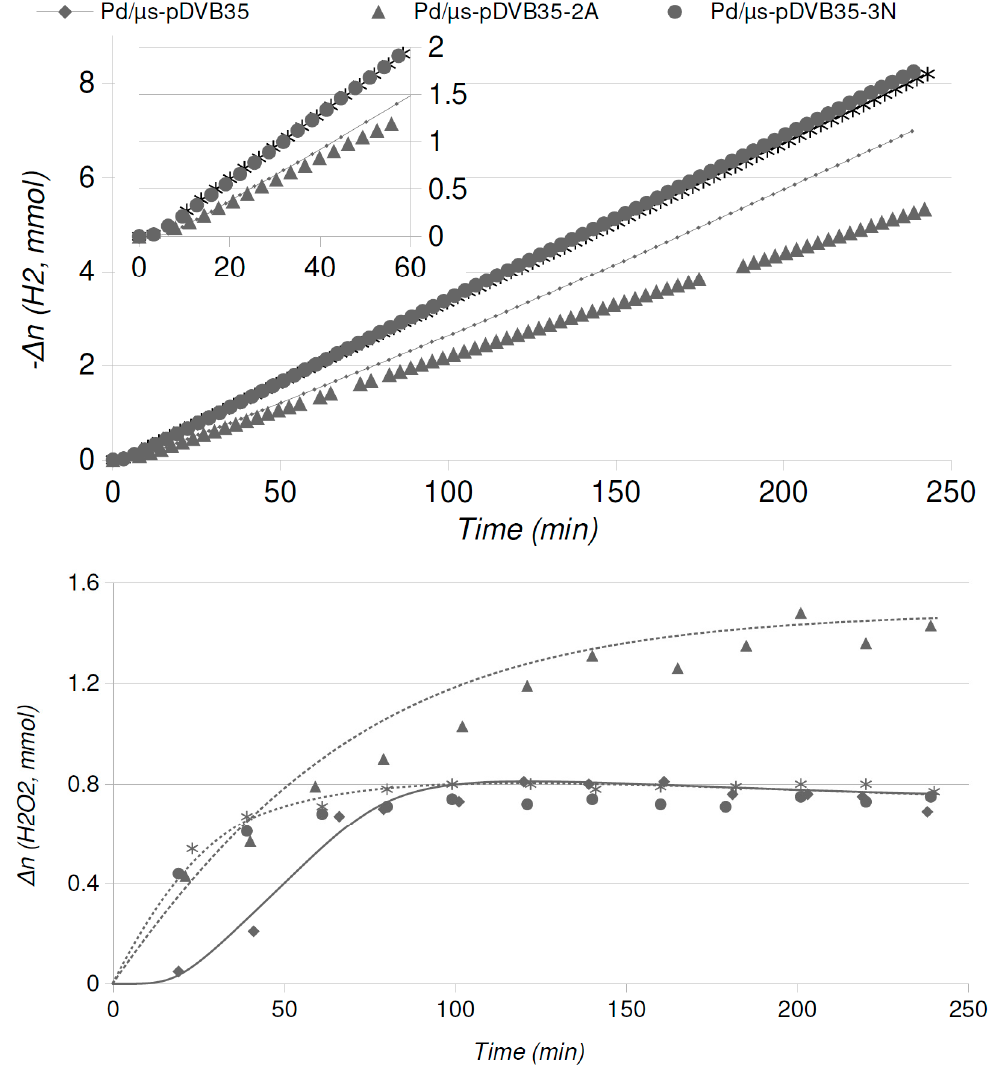
Figure 8. Overall amount of H 2 consumed ( top , mmol) and of H 2 O 2 formed ( bottom , mmol) over 100 mg of aged batches of Pd/ µ S-pDVB35 as a function of time (lines in the bottom panel are intended to serve only as guides to the eye).